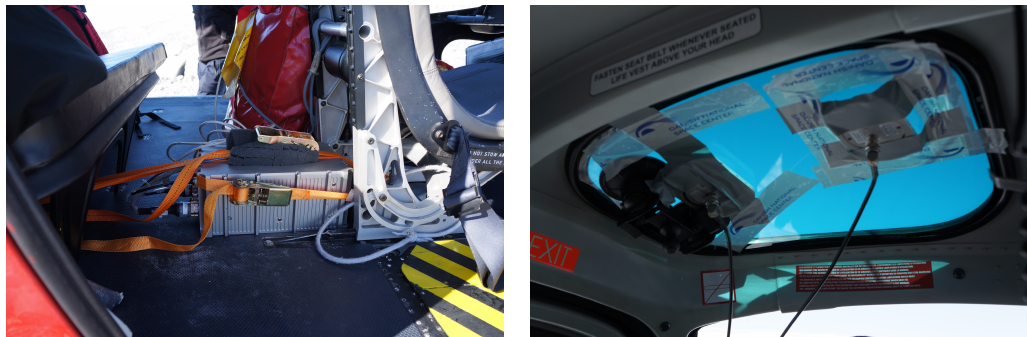
Figure 1. Photographs from the installation: ( left ) the Inertial Measurement Unit (IMU) is physically strapped to the floor of the helicopter; ( right ) the GNSS antenna is taped to the inside of the windscreen.